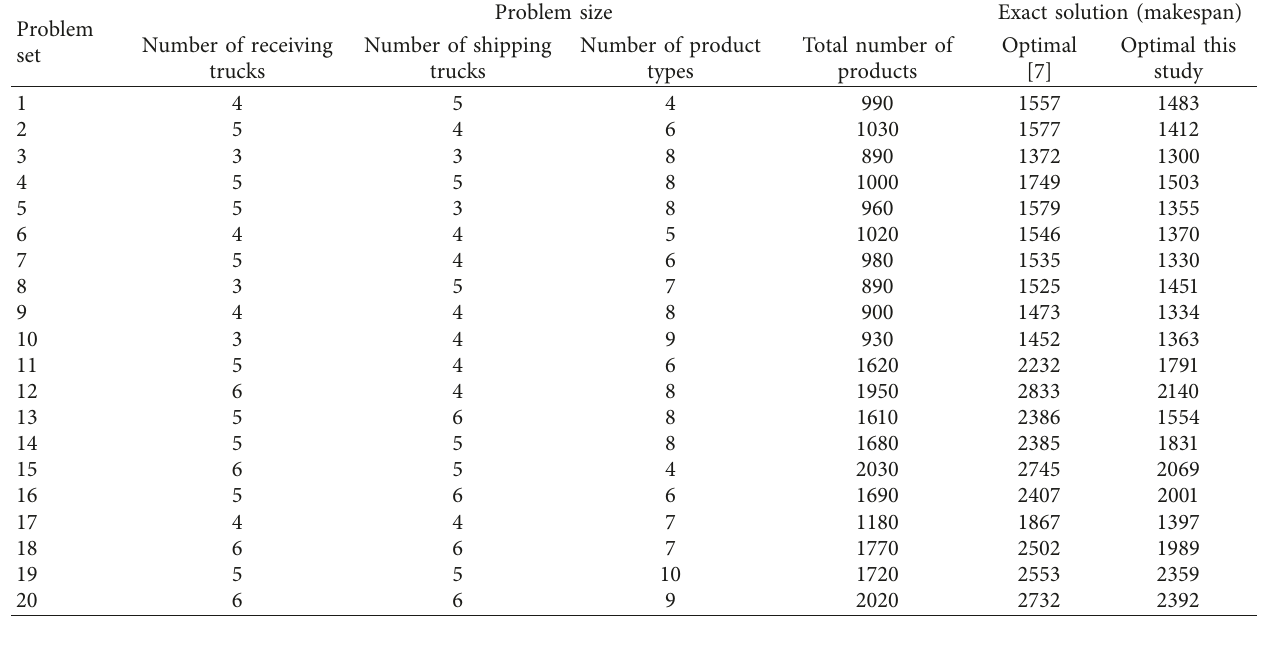
Table 2: Makespan obtained by mathematical model for the test problems.